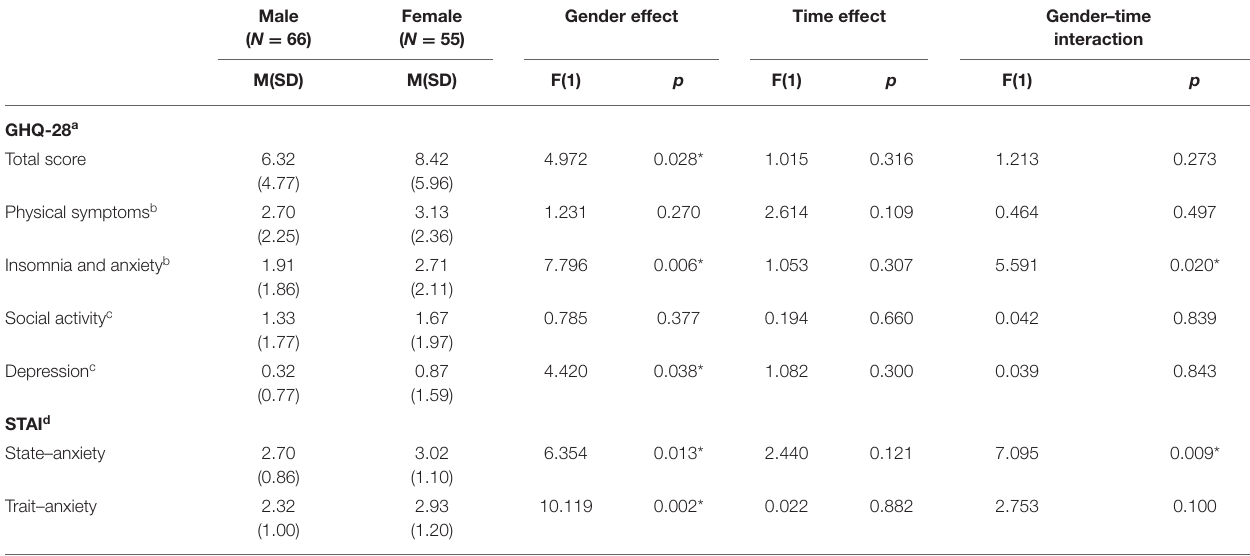
TABLE 1 | Group comparisons between male and female